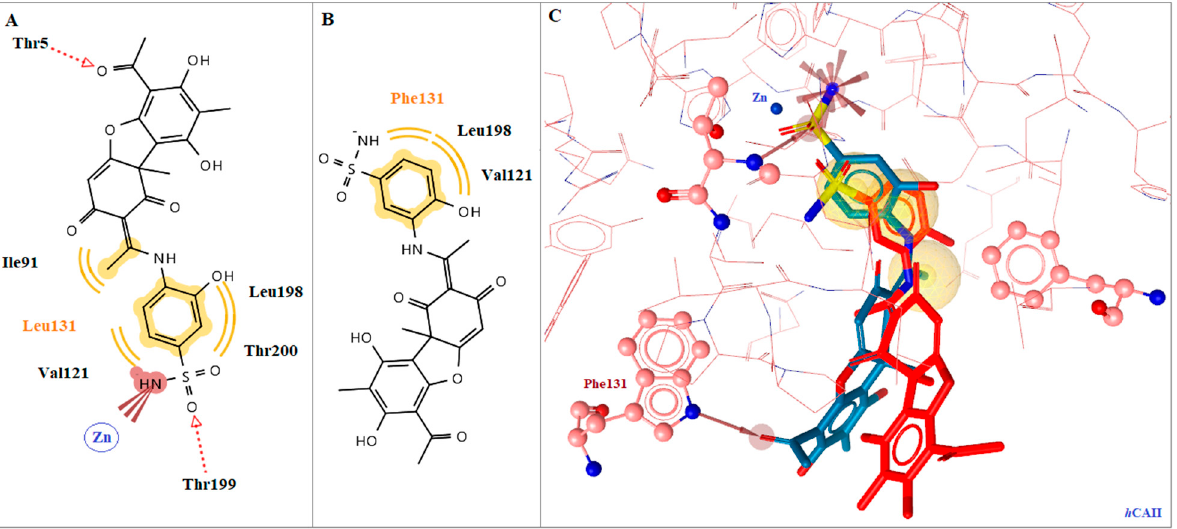
Figure 2. ( A ) 2D interaction diagram of compound 4a docking pose interactions with the key amino acids in hCA II, ( B ) 2D interaction diagram of compound 4b docking pose interactions with the key amino acids in hCA II. ( C ) Superposition of compound 4a (blue) bound to hCA II in comparison to compound 4b (red) to hCA II, with specific residues labeled. Active site zinc is shown as a blue sphere, red dotted arrows indicate H-bonds, and yellow spheres hydrophobic interactions.